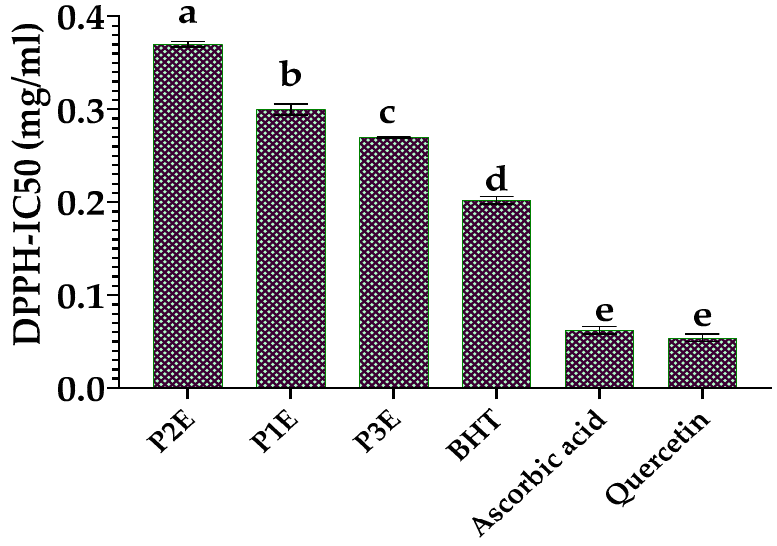
Figure 4. The IC50 values of P. rhoeas extracts, Butylated hydroxytoluene (BHT), ascorbic acid, and quercetin; a, b, c, d and e—values with a significant difference ( p < 0.05).